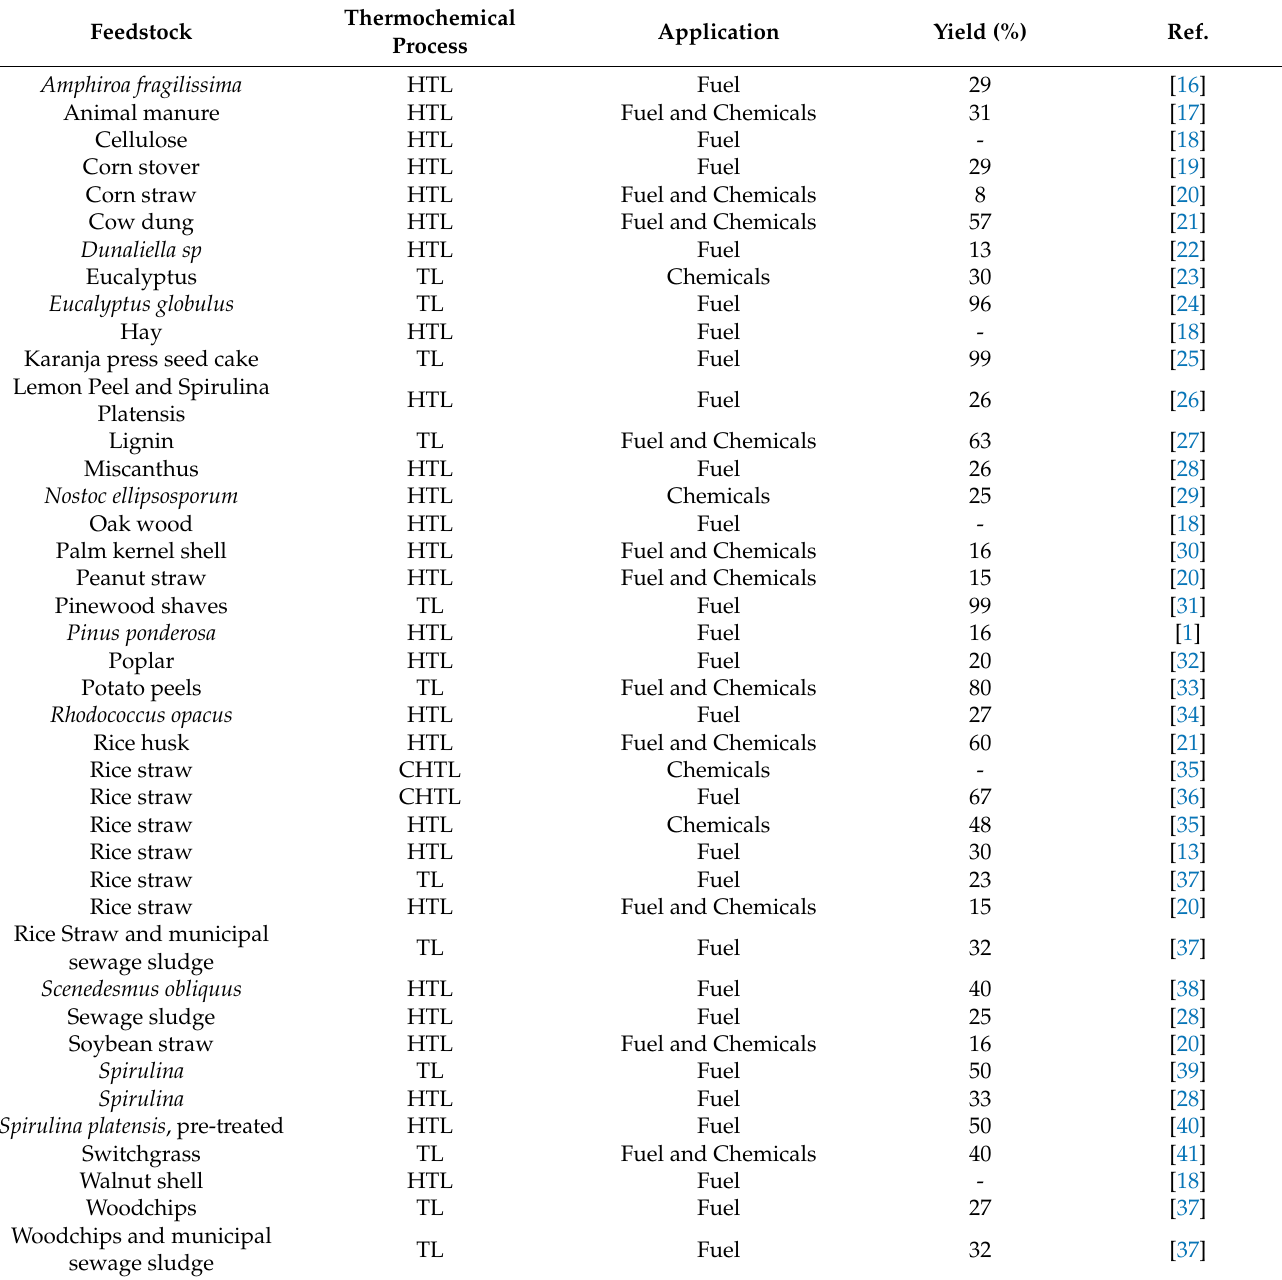
Table 1. Summary of thermochemical liquefaction bio-oil